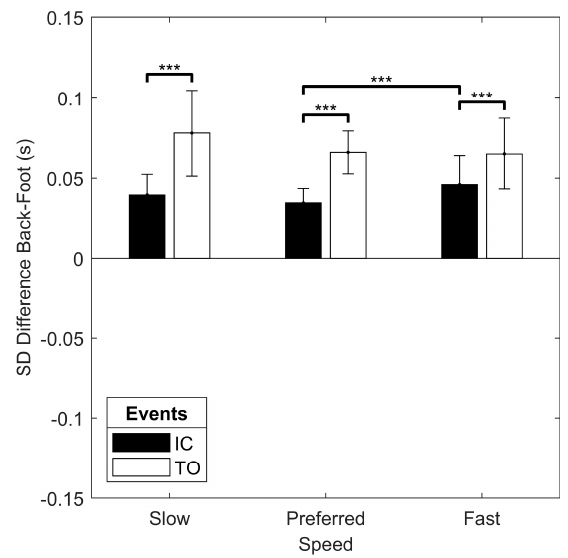
Figure 9. Results of the speed x event interaction on the standard deviation of the difference between the back and foot algorithms for the indoor track running conditions. *** simple main effect significant at p < 0.001.